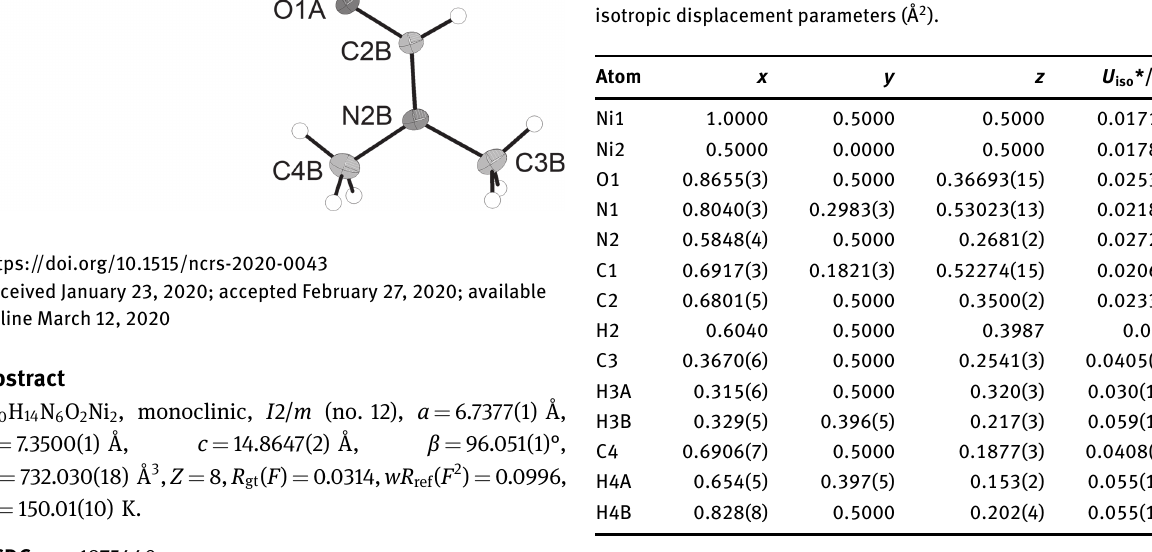
Table 2: Fractional atomic coordinates and isotropic or equivalent isotropic displacement parameters (Å 2